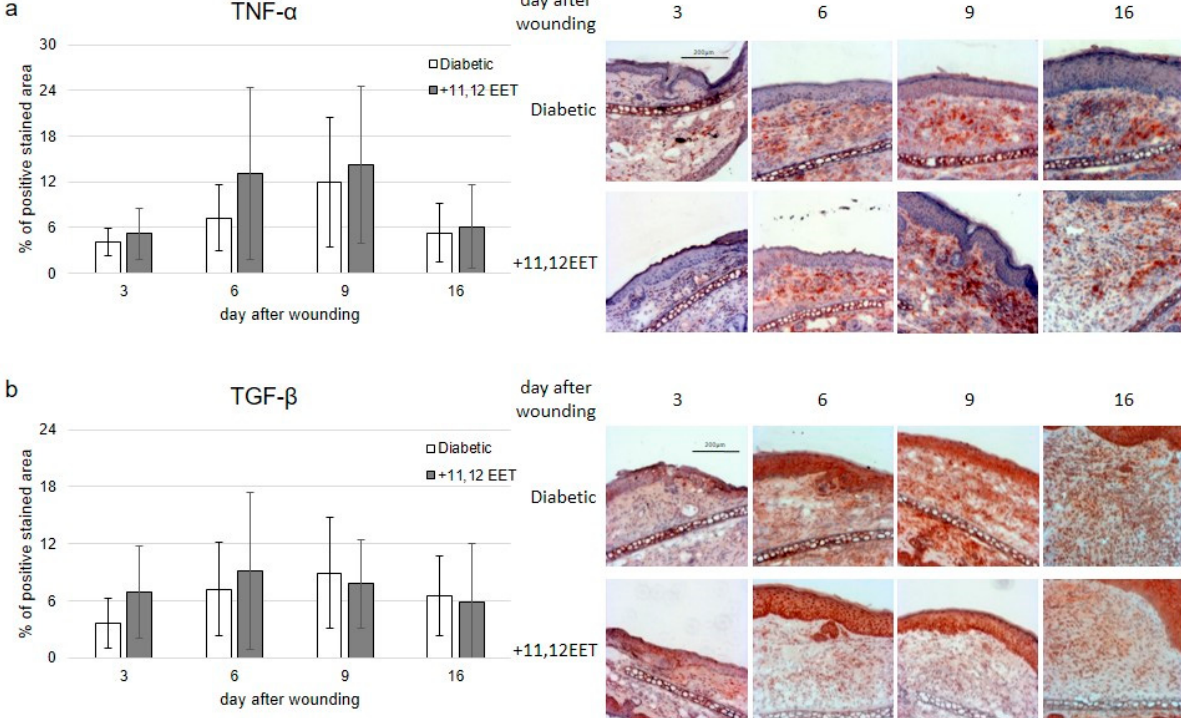
Figure 3. ( a ) Percentage of TNF- α -positive area on days 3, 6, 9, and 16 after wounding of diabetic mice without and after treatment with 11,12 EET; on the right, representative pictures of the staining. ( b ) Percentage of TGF- β -positive cells on days 3, 6, 9, and 16 after wounding of diabetic mice without and after treatment with 11,12 EET; on the right, representative pictures of the staining. (Data are shown as mean ± SD; n = 14 ).